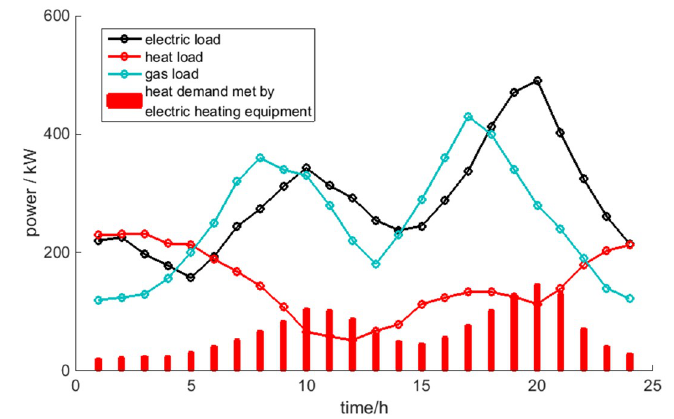
Figure 2. ( a ) Power price and gas price; ( b ) Wind and photovoltaic forecasted power. 368